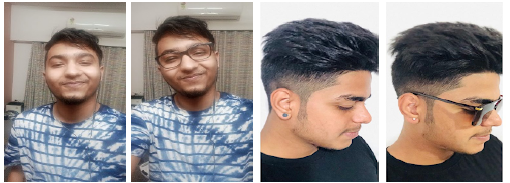
Figure 2. Examples from collected YALE database